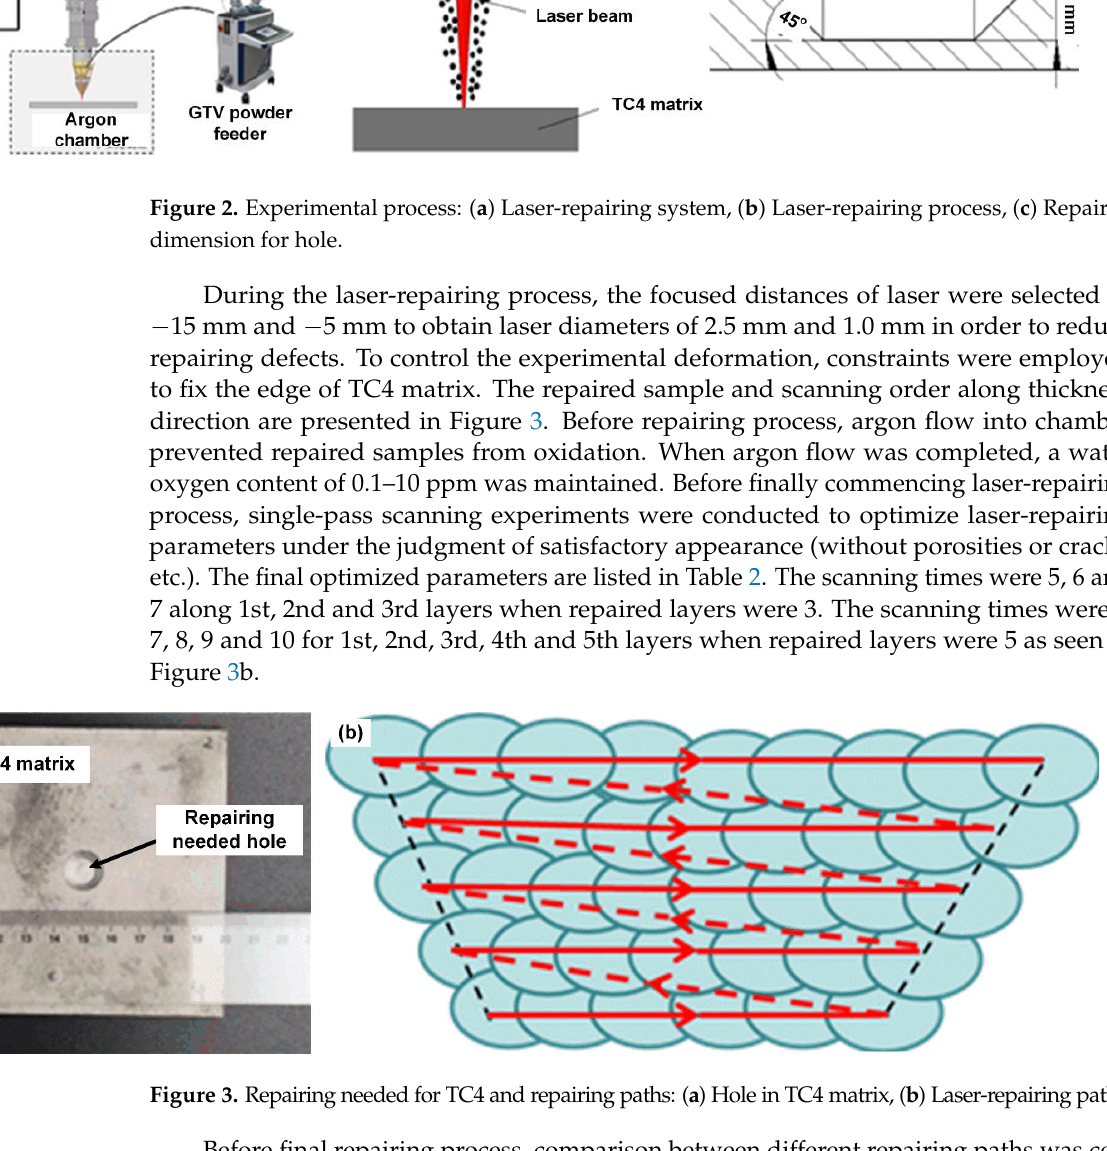
Figure 3. Repairing needed for TC4 and repairing paths: ( a ) Hole in TC4 matrix, ( b ) Laser-repairing paths.